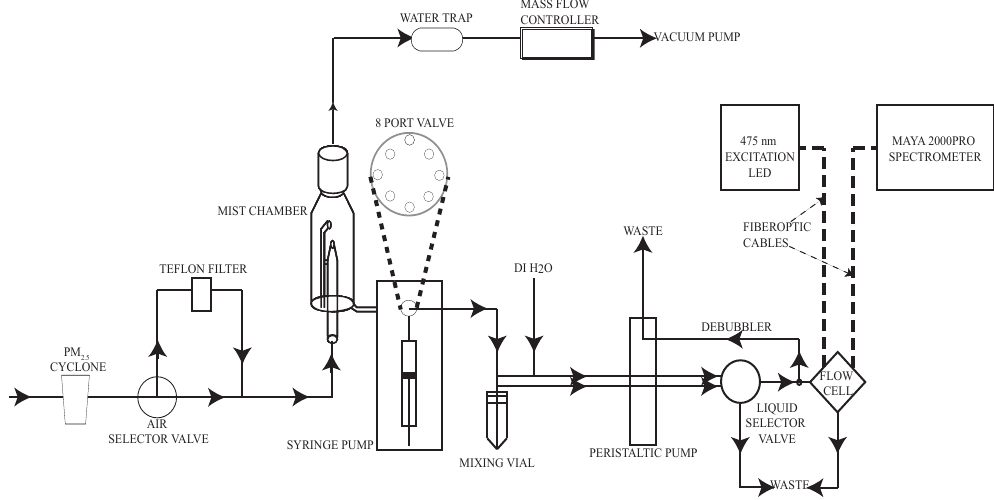
Fig. 4. Schematic of online PM 2 . 5 ROS measurement approach using a mist chamber particle collection system and fluorometric probe.